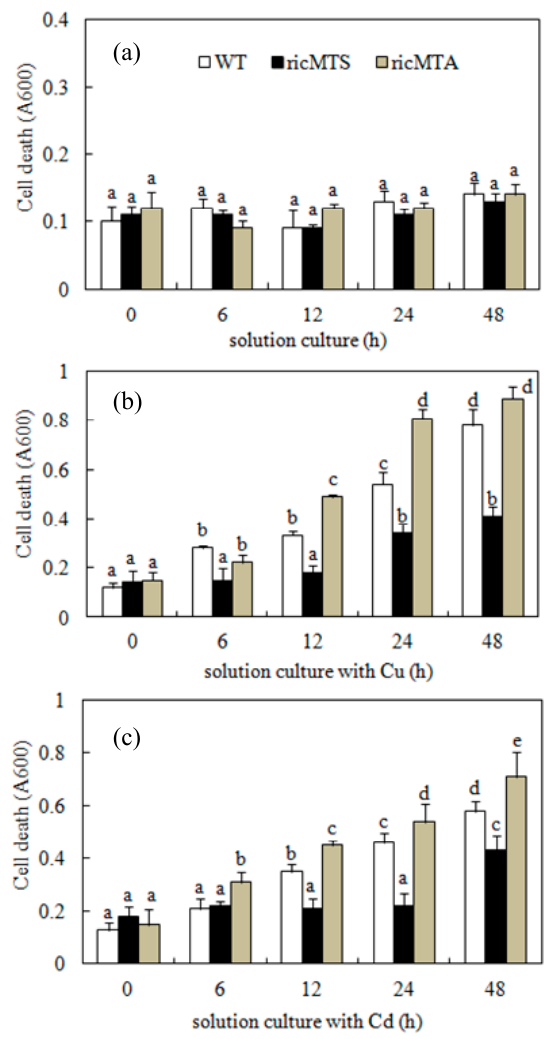
Figure 4. Effect of treatment of Cu and Cd on cell death of rice suspension cells. ( a – c ) Rice suspension cells were cultured with control medium ( a ), medium with 100 μ M CuSO 4 ( b ) or medium with 100 μ M CdCl 2 ( c ) for various times (0, 6, 12, 24, and 48 h). Subsequently, aliquots of the suspension cells were stained with Evans blue. Cells were then washed to remove excess stain, ground with a micro-sample pestle in the presence of 0.5% SDS to release trapped stain. The A600 of the supernatant was used to monitor cell death. WT represents the wild-type rice suspension cells; ricMTS and ricMTA respectively represent rice suspension cells of the sense- ricMT lines ricMTS2 and antisense- ricMT lines ricMTA2. Values are means ± SE ( n = 3) of three separate experiments. Means denoted by the same letter did not significantly differ at p < 0.05 according to Duncan’s multiple range test.